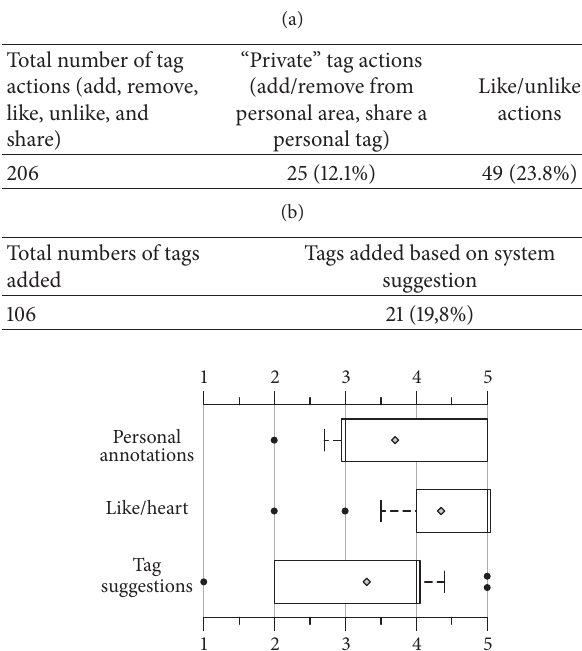
Figure 5: Users’ assessment of the usefulness of each support mechanism.